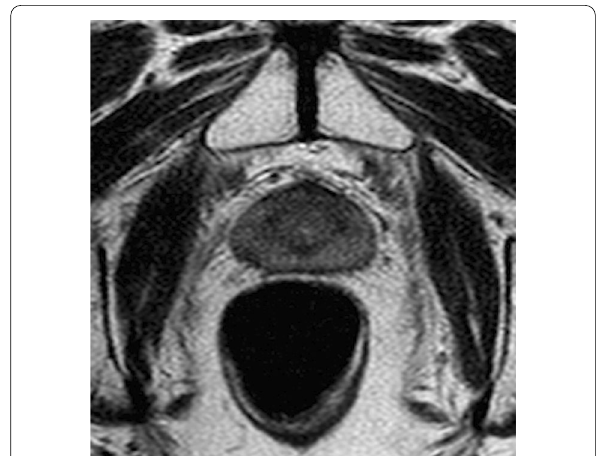
Fig. 22 Follow-up MRI scan performed by a 67-year-old man with low-risk prostate cancer 12 months after external beam RT. Axial T2-weighted image shows the loss of zonal differentiation of the